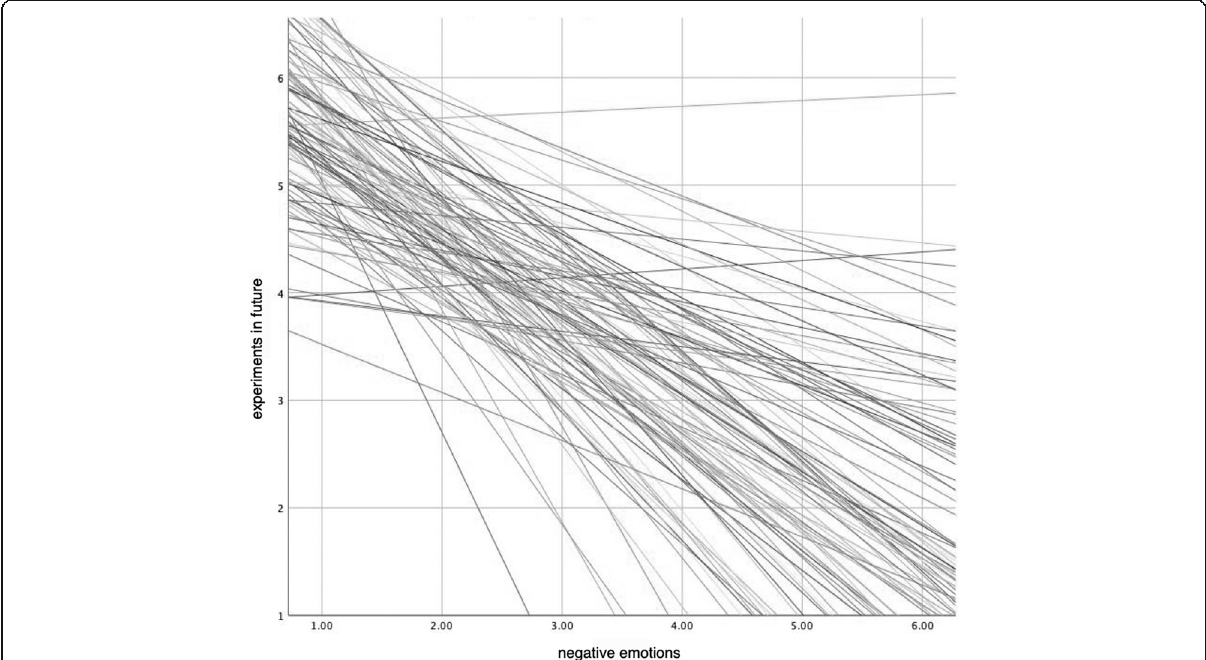
Fig. 3 OLS-Regression for momentary intention to apply experiments in the future on momentary negative emotions separated for each student. The dotted line represents the mean regression line